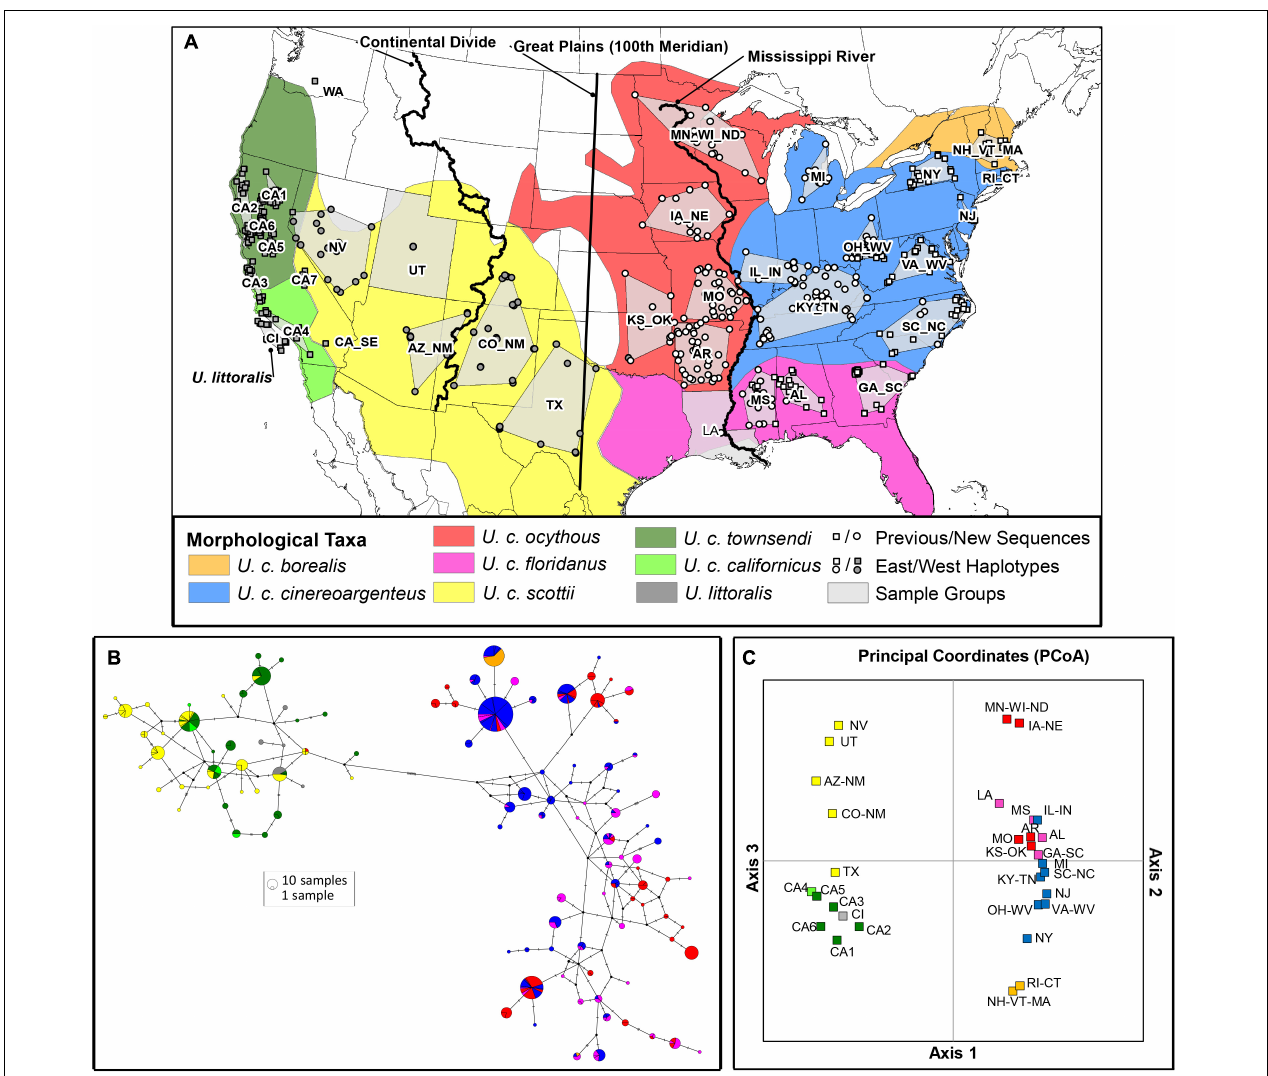
FIGURE 1 | Analysis of 400 bp mtDNA control region sequence data from samples of gray fox ( Urocyon spp.). (A) Map shows the ranges of 7 morphologically-based gray fox ( U. cinereoargenteus ) subspecies (Hall, 1981) and the island fox ( U. littoralis ); the locations of sample groups ( n = 34) and samples ( n = 781) used in the analysis, including newly generated sequences (circles), and previously published sequences (squares; Bozarth et al., 2011; Goddard et al., 2015; Hofman et al., 2015); and 3 possible locations of a hypothesized secondary contact zone between deeply divergent eastern and western gray fox lineages (Goddard et al., 2015). Samples are colored according to whether its haplotype fell into the East (white) or West (black) clade. (B) Median joining haplotype network. Each circle represents a unique haplotype, with size proportional to frequency, as well as a pie chart with color indicating the morphologically-based taxonomic assignment of the corresponding samples. Black circles reflect inferred haplotypes not present in the dataset, and hash marks on the lines connecting haplotypes represent the number of mutations separating them. A minimum of 13 steps separates East and West haplotypes. (C) Principal coordinates plot from population pairwise Fst (K2P-corrected) values, with sample groups colored according to morphologically-based taxa shown in the map. The first axis explained 47.8% of the variation and clearly divided western from eastern sample groups at the Great Plains, the second axis explained 11.3% of the variation and separated sample groups within the East (note only scores for East sample groups are shown since West sample groups had scores near 0 for the second axis), and the third axis explained 7.9% of the variation and separated sample groups within the West (note only scores for West sample groups are shown since East sample groups had scores near 0 for the third